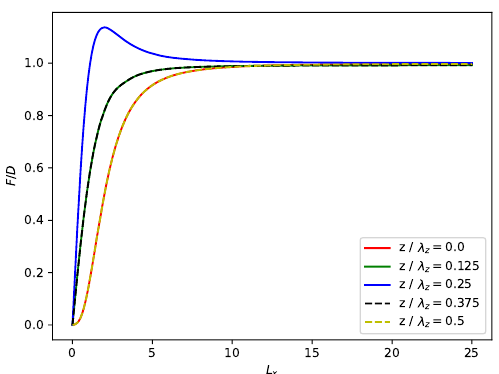
Figure 1. Relative total momentum flux F / D as a function of integral length L x at different heights. Note: periodicity means the z / λ z = 0.0 and z / λ z = 0.125 lines correspond exactly to the z / λ z = 0.5 and z / λ z = 0.375 lines,